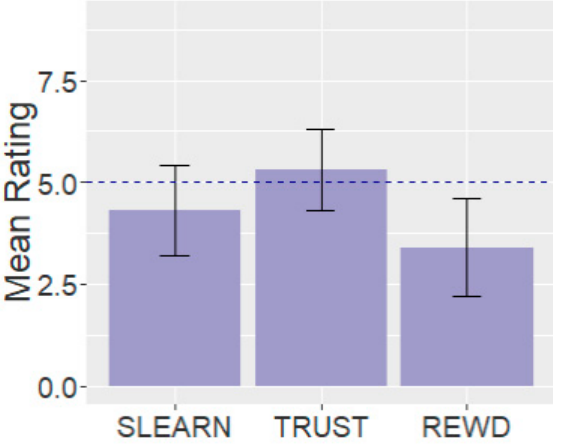
Figure 1. Overall mean rating of the persuasive strategies (SLEARN = social learning, TRUST = trustworthiness, REWD = reward; horizontal bar indicates the neutral of five on the 1–9 Likert scale).